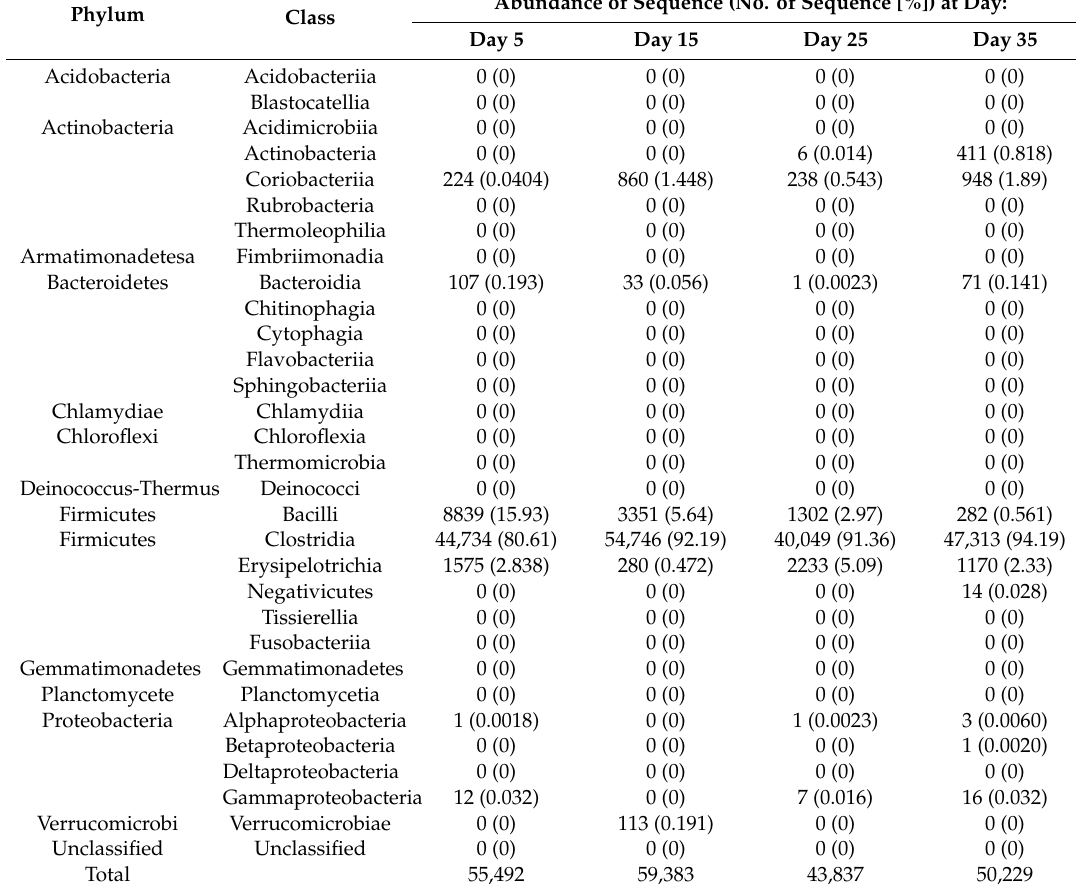
Table 4. Abundance of bacterial 16S rDNA sequences ( n = 208,941) identified from the cecum microbiota of Cobb 500 broiler